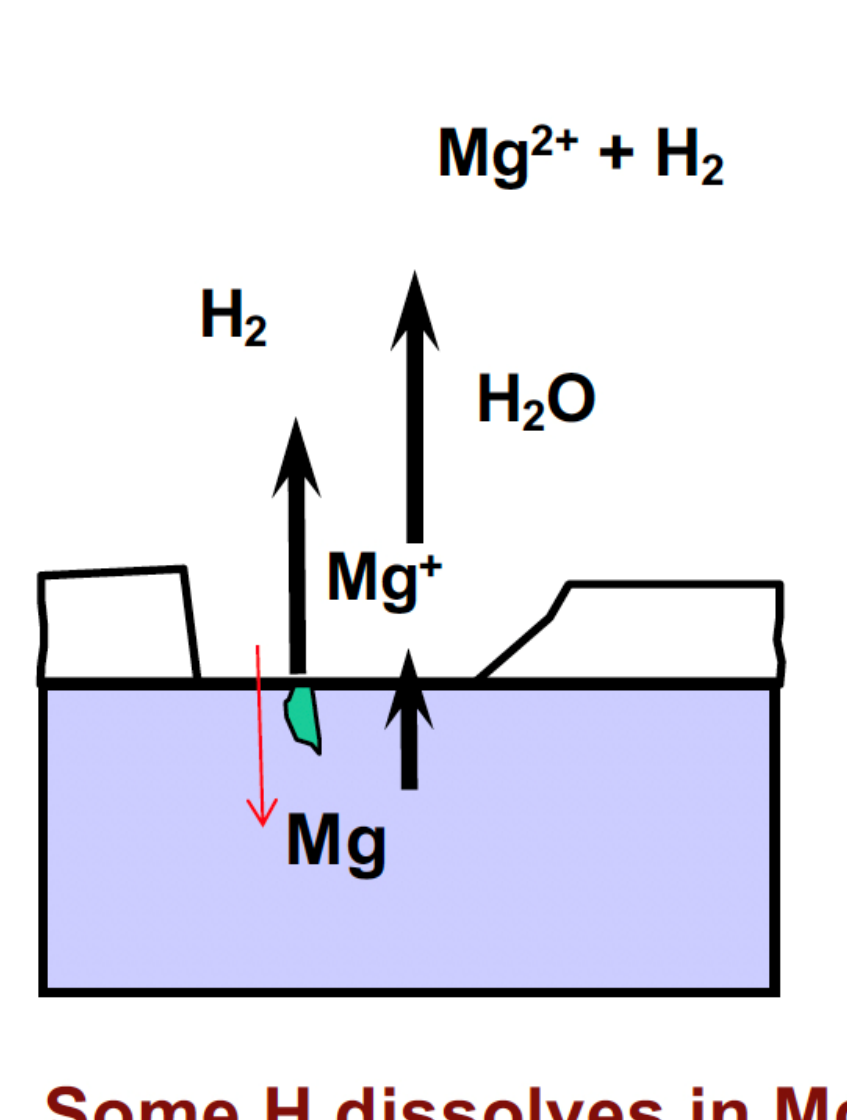
Figure 18. A schematic of the Mg corrosion mechanism. The anodic reaction occurs in two steps via the uni-positive Mg + ion that is sufficiently reactive to chemically split was to produce hydrogen.